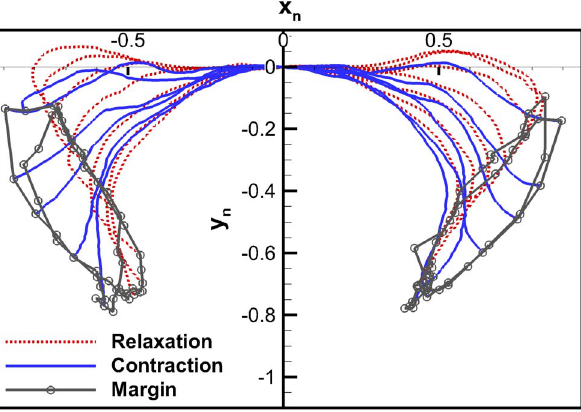
Fig. 7. Corrected kinematics. Cyanea capillata exumbrella profiles are shown during a full cycle. The profiles were arbitrarily selected over the first cycle of the swimming sequence to demonstrate the different geometries encountered. Bell margin trajectory is shown for two consecutive cycles. The positions are normalized by the half exumbrella arclength in the relaxed position.